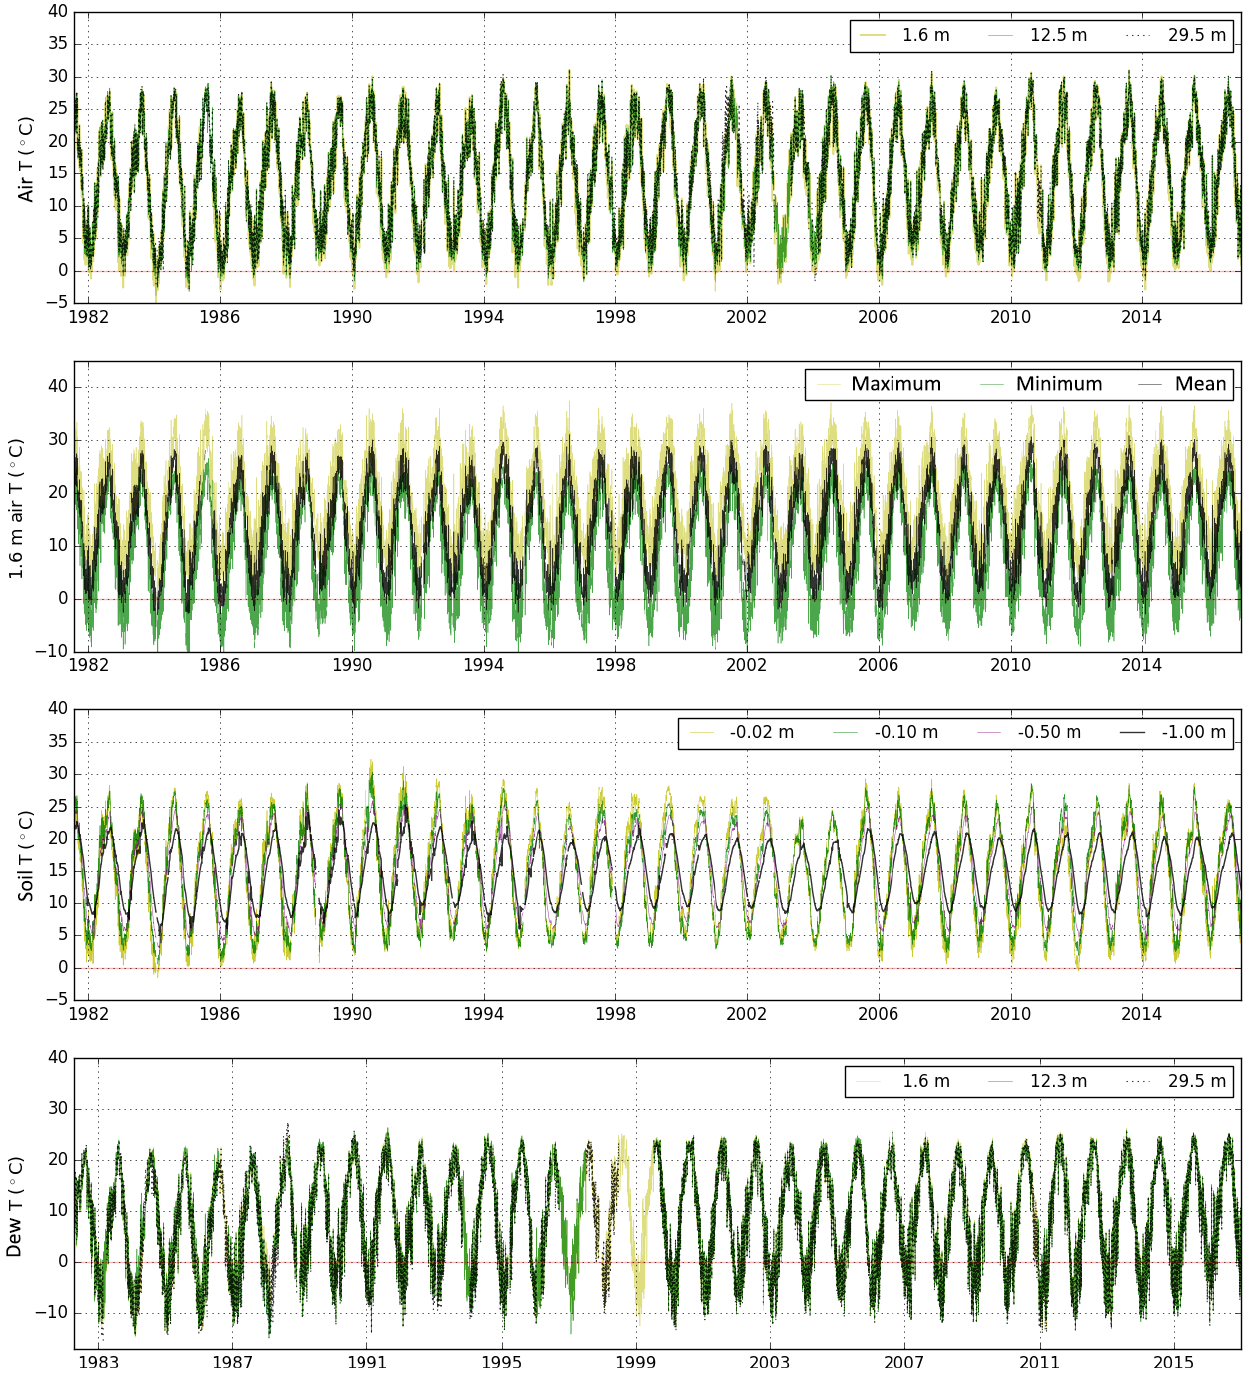
found. That the estimated longwave radiation has a positive trend is consistent with the air-temperature trend with ref- erence to the Stefan–Boltzmann law (Shuttleworth, 2011). Since the shortwave radiation has increased, it is reasonable to expect the net radiation to have increased as well, because